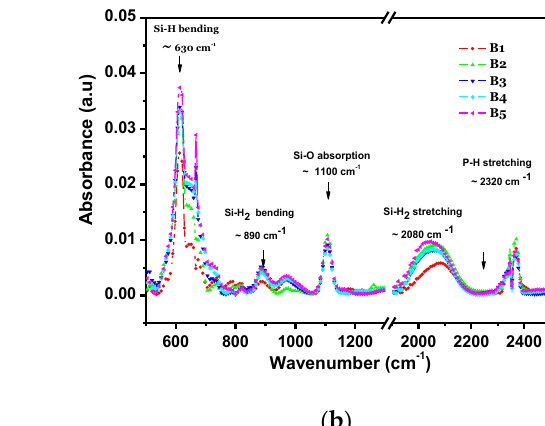
Figure 1. FTIR spectra for a−Si:H for two series of thin films: ( a ) n−type films with different H 2 and PH 3 contents; ( b ) p−type films with different H 2 and B 2 H 6 contents.